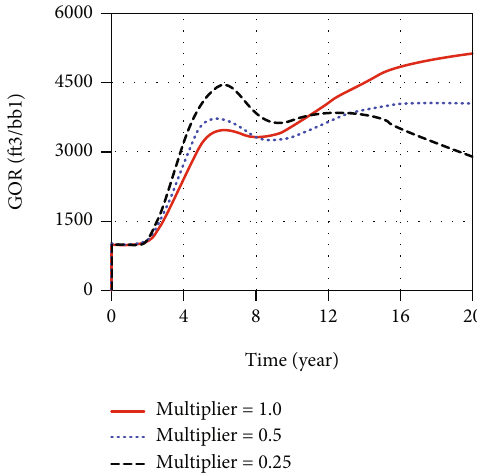
Figure 8: Simulated cases showing dependence of GOR on matrix multiplier (the ratio of vertical to horizontal permeability). Larger multipliers enhance the gas movement and then increase the GOR rise in the late time